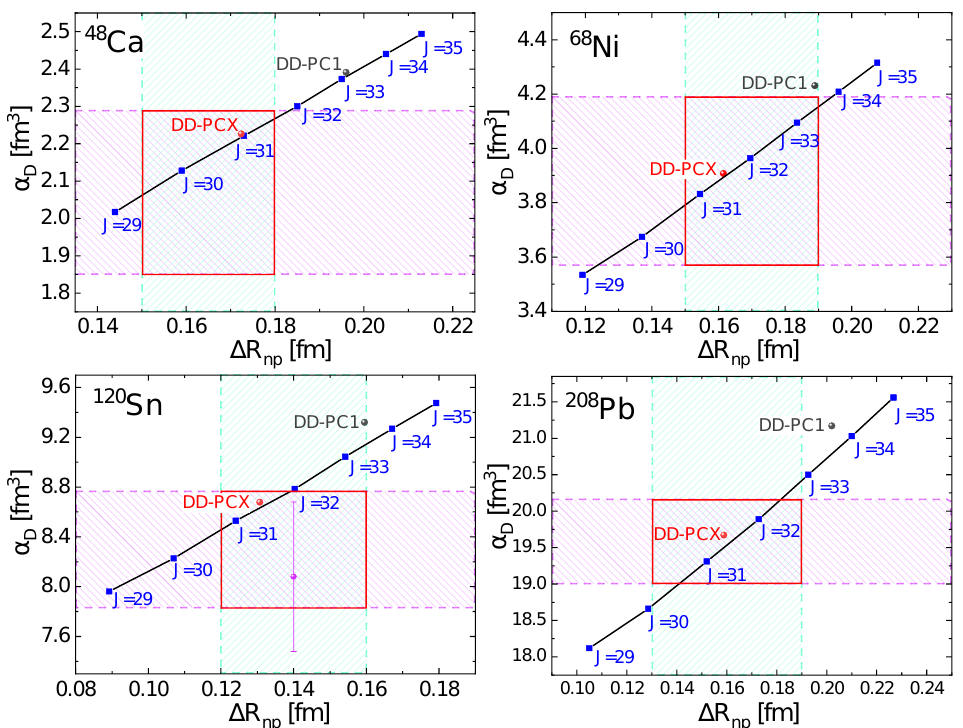
Figure 5. Dipole polarizability as a function of neutron skin thickness for 48 Ca, 68 Ni, 120 Sn and 208 Pb using the relativistic point-coupling functionals. The experimental data for the dipole polarizability values are taken from References [55–60]. The recent experimental data for 120 Sn is taken from Reference [58] and displayed ( α D = 8.08 ± 0.6 fm 3 ) with the violet shaded sphere. The band for the neutron radii represents the model-averaged results using many functionals (see Reference [60] for more